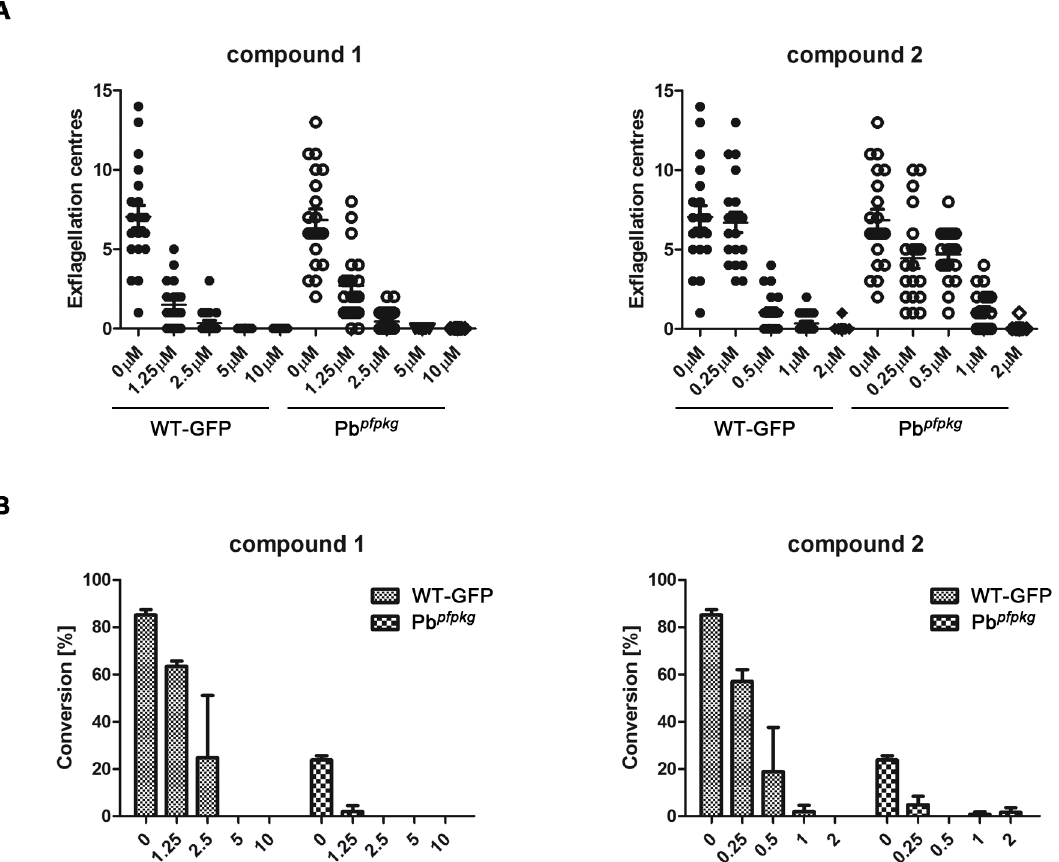
Figure 4. Inhibition of exflagellation and ookinete conversion using PKG inhibitors. A) Inhibition of exflagellation: exflagellation was measured in the presence of increasing concentrations of compound 1 and compound 2 on both WT GFP line expressing PbPKG (WT-GFP) and the transgenic line expressing PfPKG (Pb pfpkg ) Bar, arithmetic mean 6 SEM. B) Inhibition of ookinete conversion: ookinete conversion was determined in the presence of increasing concentrations of compound 1 and compound 2 in WT-GFP and the transgenic Pb pfpkg line as above. Data shown as mean 6 SD.